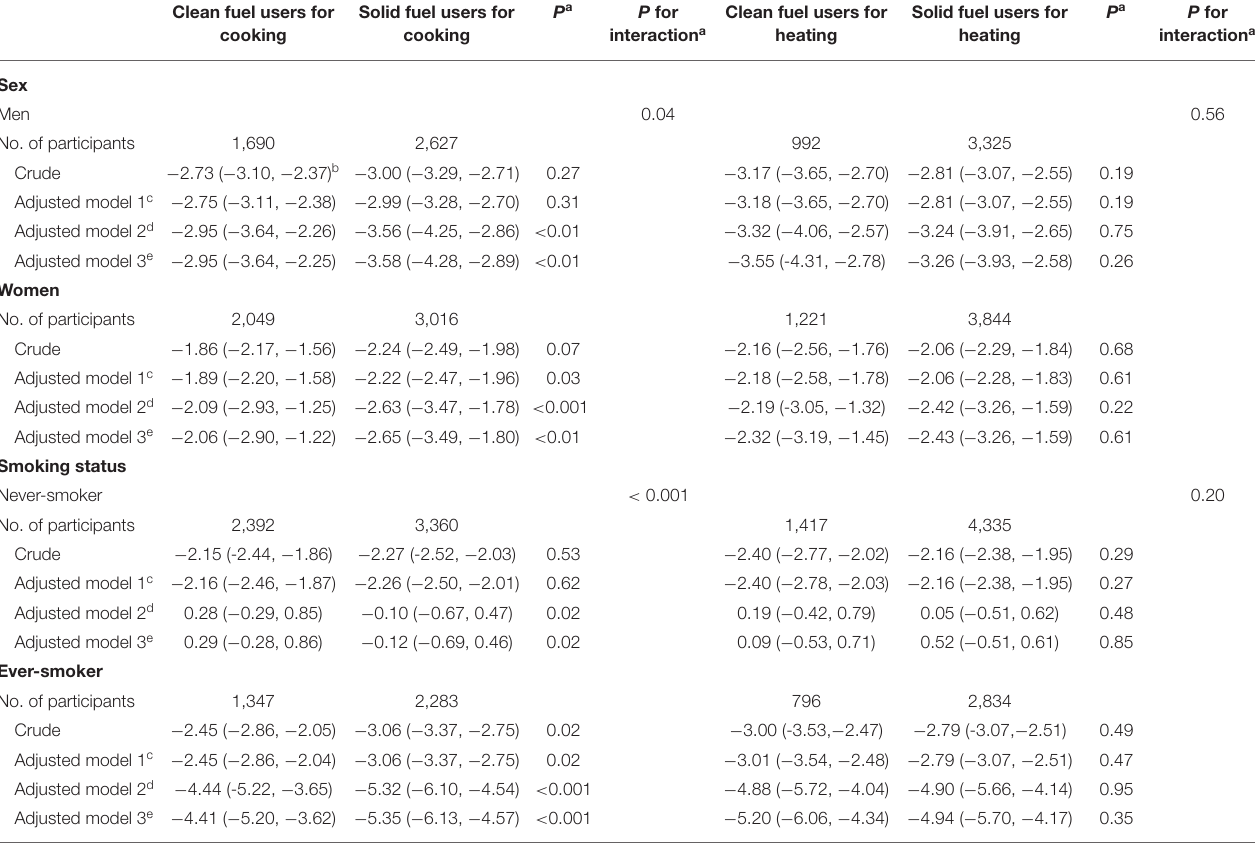
HGS, handgrip strength. * Changes of HGS: HGS in 2015 minus HGS in 2011. a Analysis of covariance. b Least square mean (95% confidence interval) (all such values). c Adjusted for age, sex, and body mass index. d Additionally adjusted for educational level, smoking status, drinking status, marital status, place of residence, participation in social activities, number of chronic diseases,